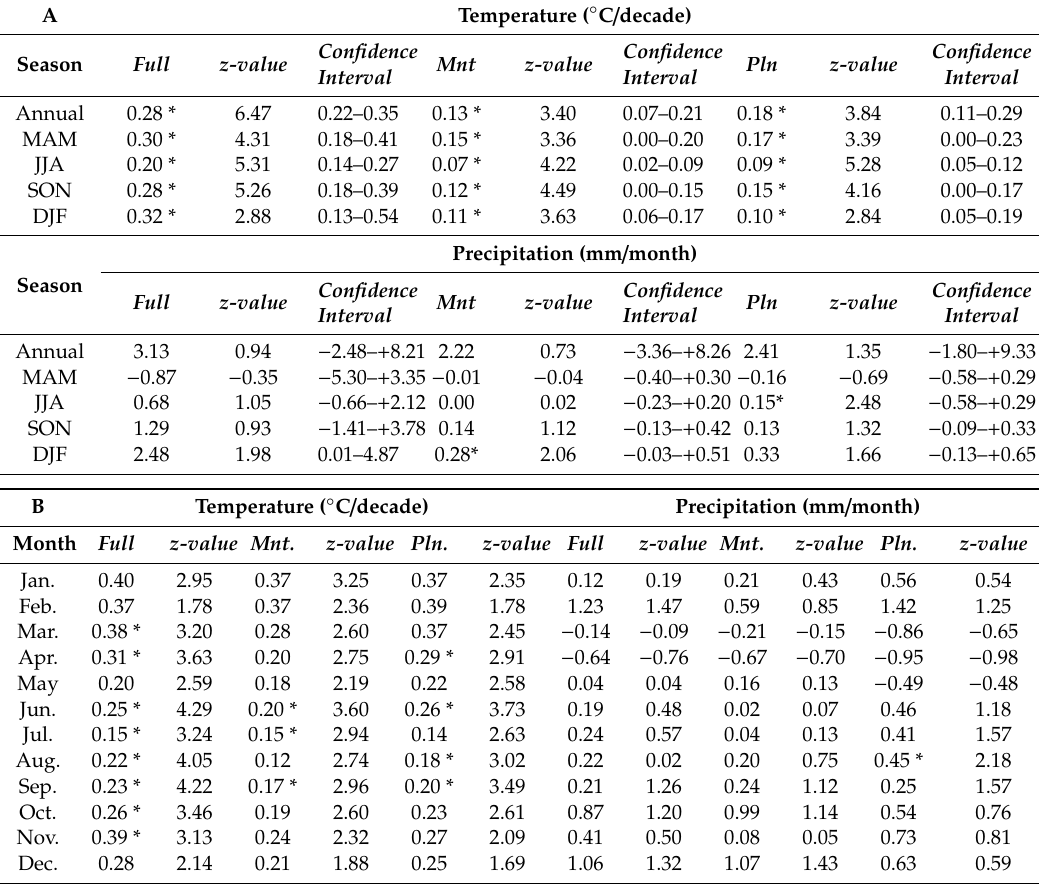
Table 3. Linear trends of seasonal (A) and monthly (B) temperature and precipitation during 1950–2016 by Sen’s slope method using a pre-whitened time series. Trend magnitudes, confidence intervals for sens slope, and z-statistics are calculated for the full area ‘ Full ’ and for mountainous regions ‘ Mnt ’ and lower plains ‘ Pln ’. * Indicates significance at the 95% confidence